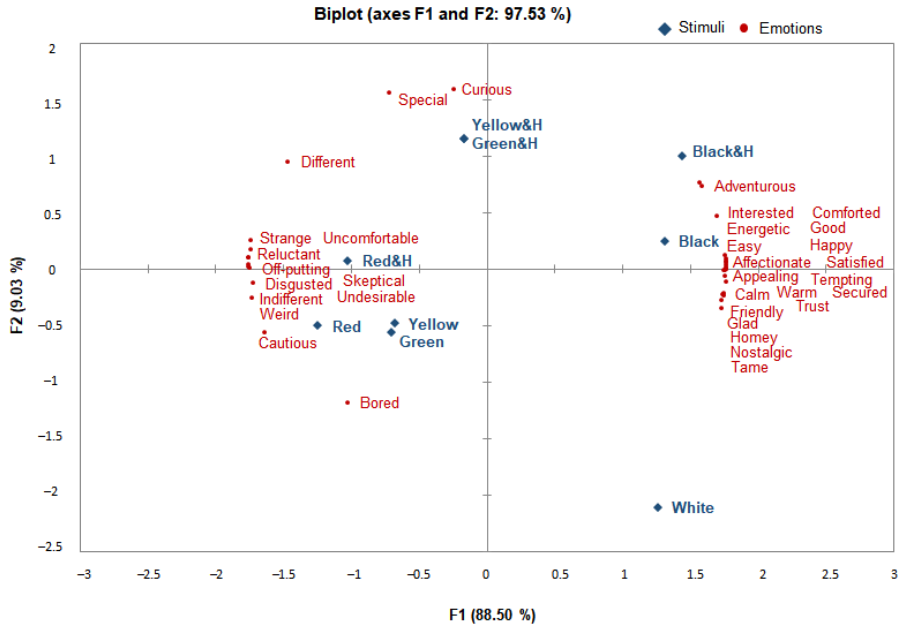
Figure 2. Principal component analysis (PCA) biplot showing the emotion profile elicited by the CO and CO&H of colored rice in the Korean respondents.